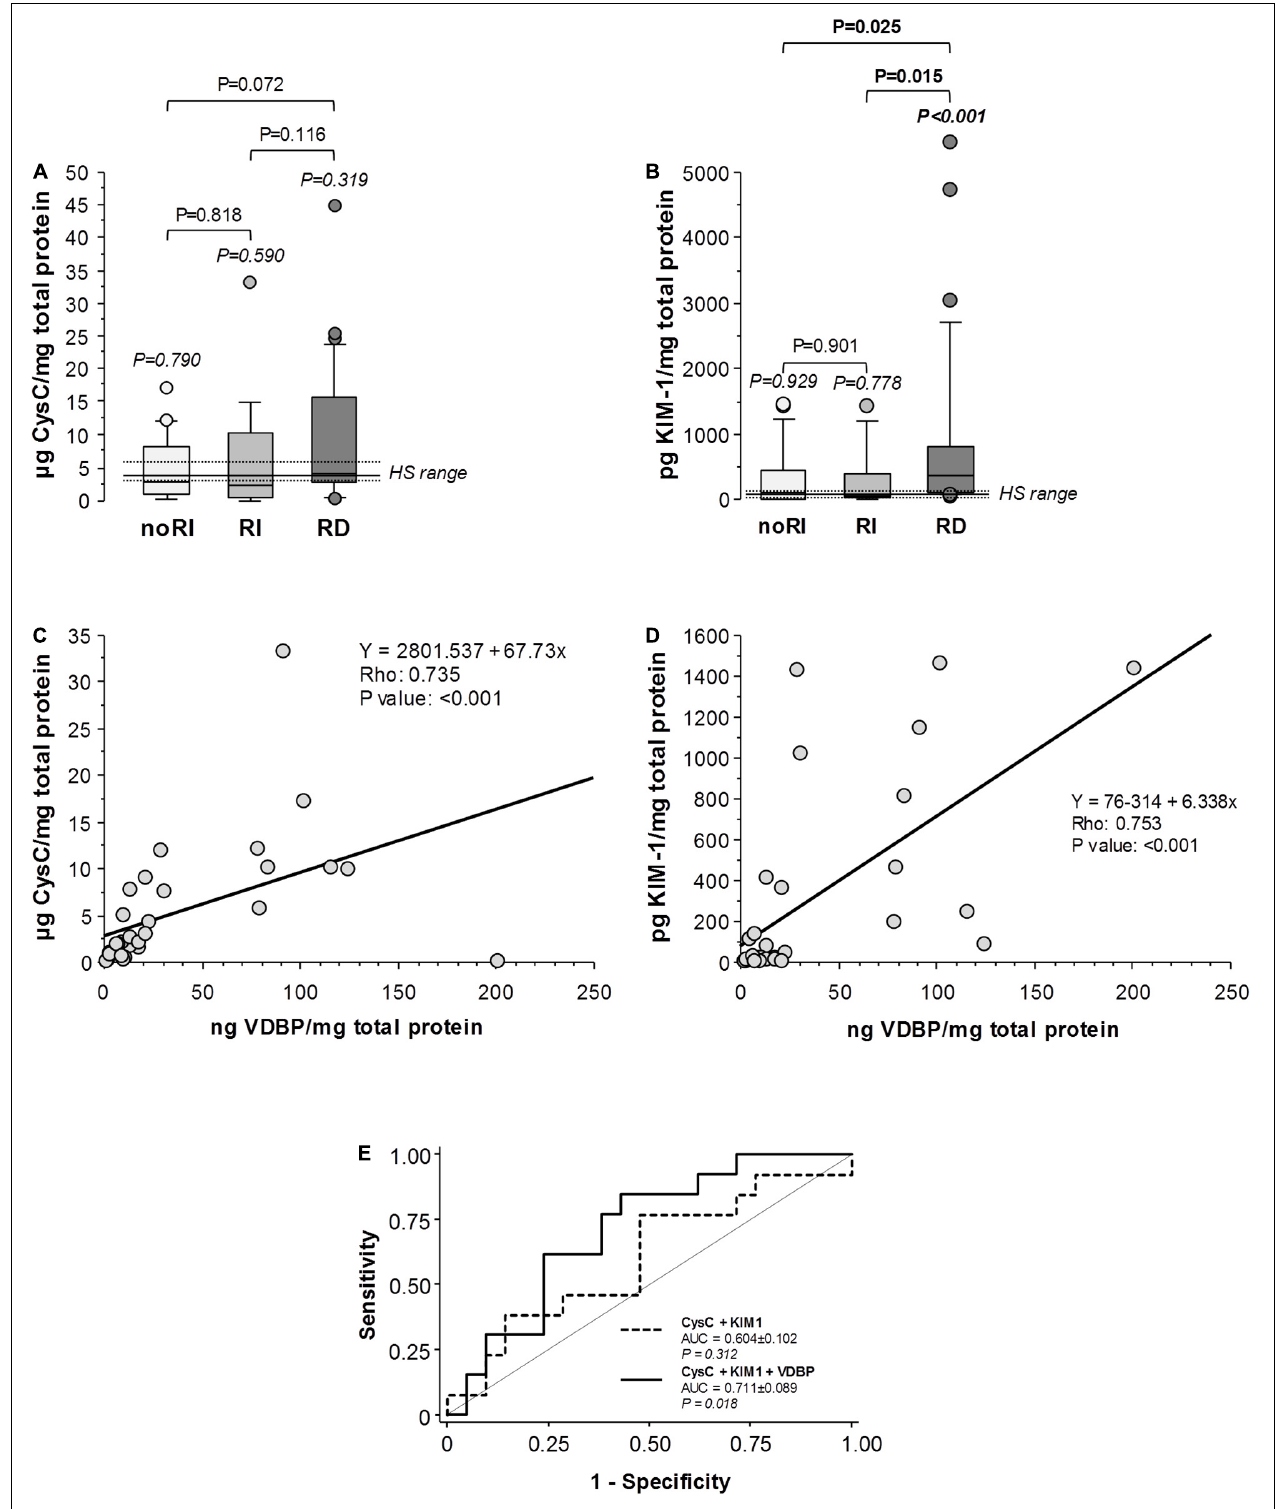
FIGURE 5 | Markers of tubular damage (urinary CysC and KIM-1) in patients with ADHF at day 3 of hospitalisation. Box plot diagrams [median (IQR)] refer to (A) cystatin C (CysC) and (B) Kidney Injury Molecule 1 (KIM-1) in the subgroups of patients with ADHF as described in Figure 4A . (C,D) Spearman correlation (Rho) between urinary VDBP levels and CysC and KIM-1, respectively, in all patients with ADHF. (E) ROC curve analyses (C-Statistics) for the prediction of renal function deterioration presentation in patients with ADHF ( N = 34). AUC indicates area under the curve.